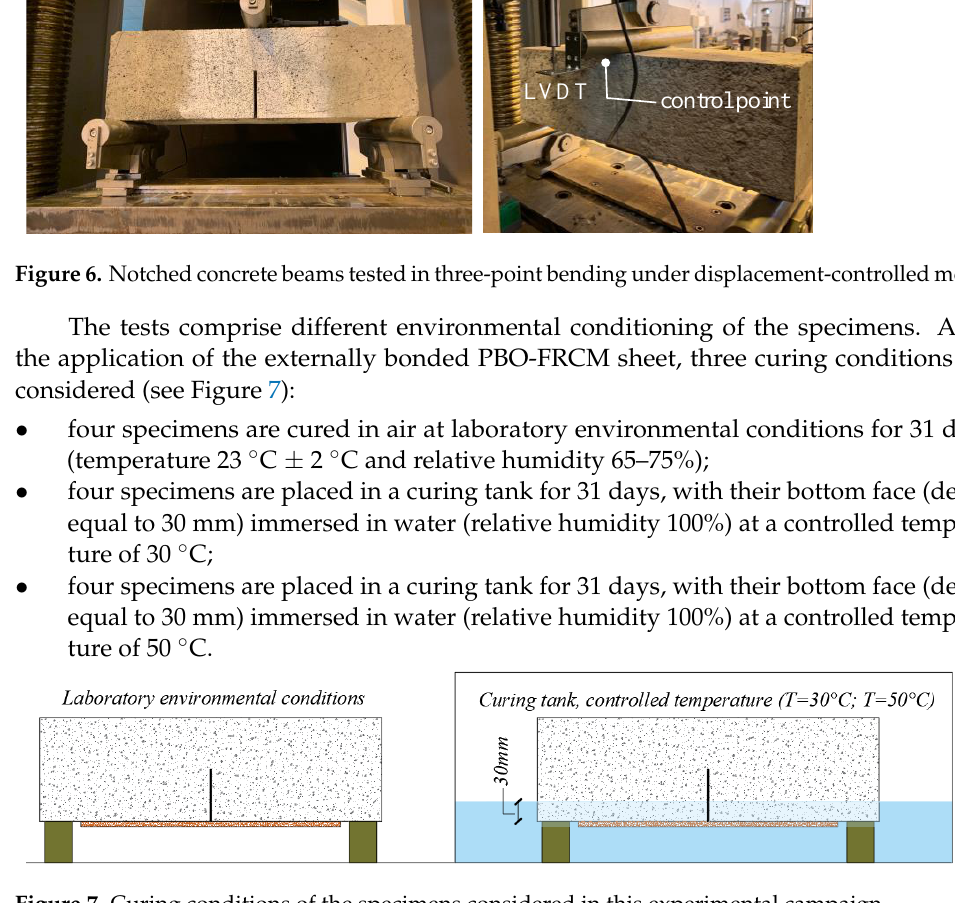
2 of 10 Figure 4. Final configuration of concrete beams with externally bonded PBO-FRCM sheet: front view ( top ) and bottom view ( bottom ). All sizes are reported in mm.